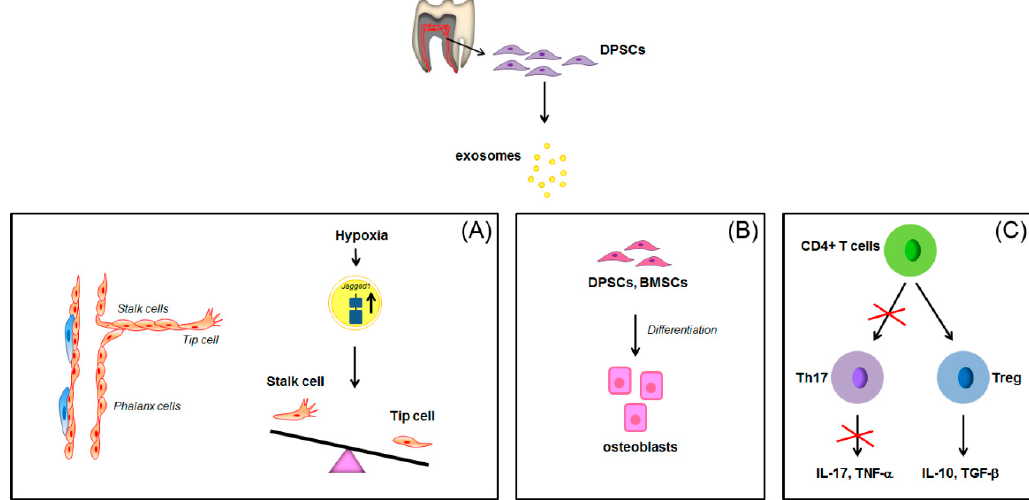
Figure 3. Schematic representation of the paracrine effects of exosomes derived from DPSCs in angiogenesis, osteogenic differentiation and CD4+ cells alternative differentiation. Jagged1 overexpression in hypoxic DPSCs-derived exosomes antagonizes Dll4 in Notch binding, promoting angiogenesis and increasing the number of tip cells ( A ). Exosomes derived from DPSCs induce osteogenic differentiation of DPSCs and BMSCs ( B ) and induce Treg differentiation of CD4+ cells ( C ).